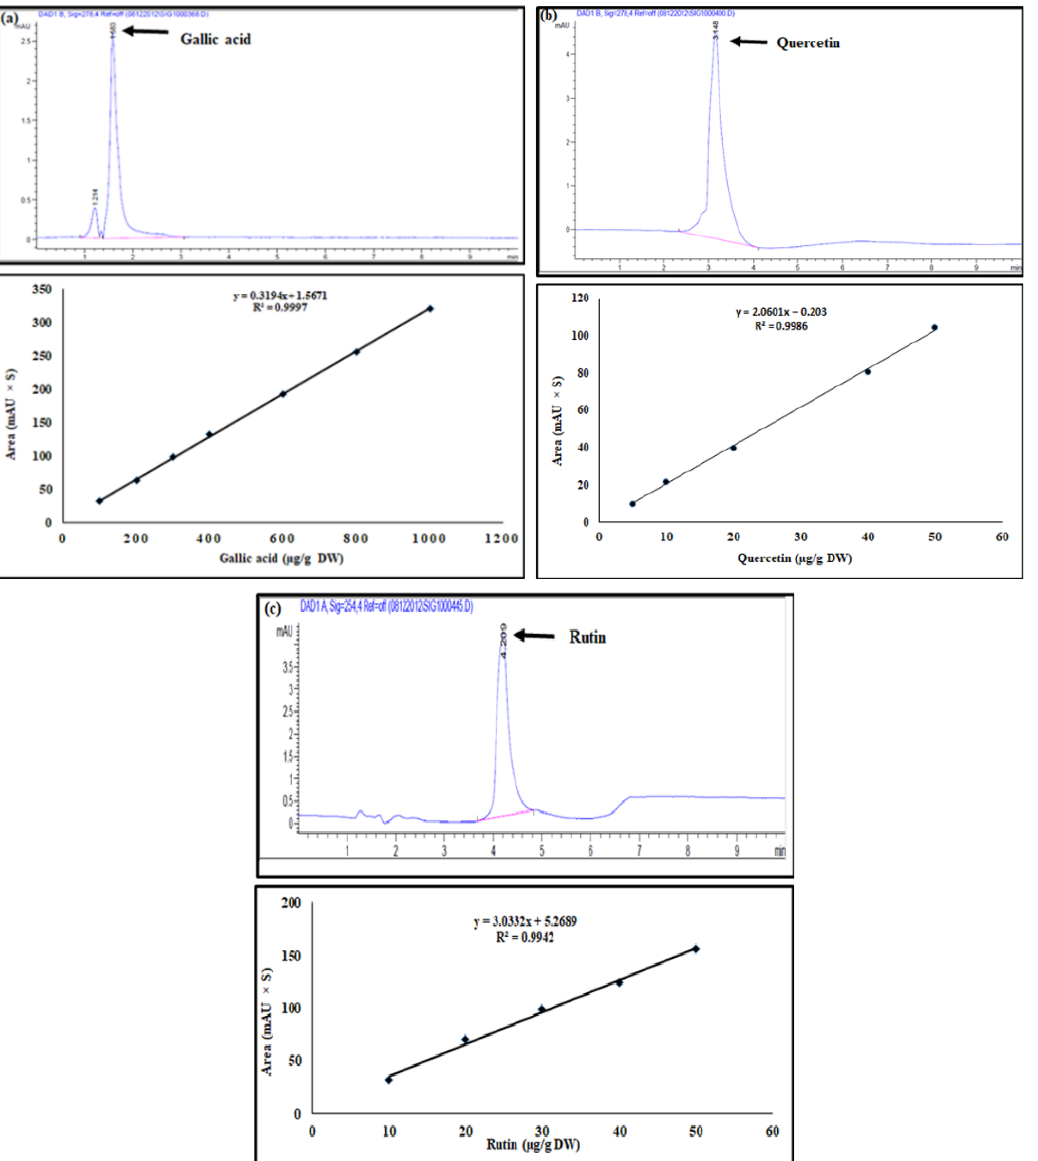
Figure 5. HPLC chromatogram of the standards ( a ) gallic acid, ( b ) quercetin, and ( c ) rutin and their calibration plots. Table 1. Gallic acid, quercetin, and rutin content (µg/g DW) in the leaf and callus extracts. Plant Material